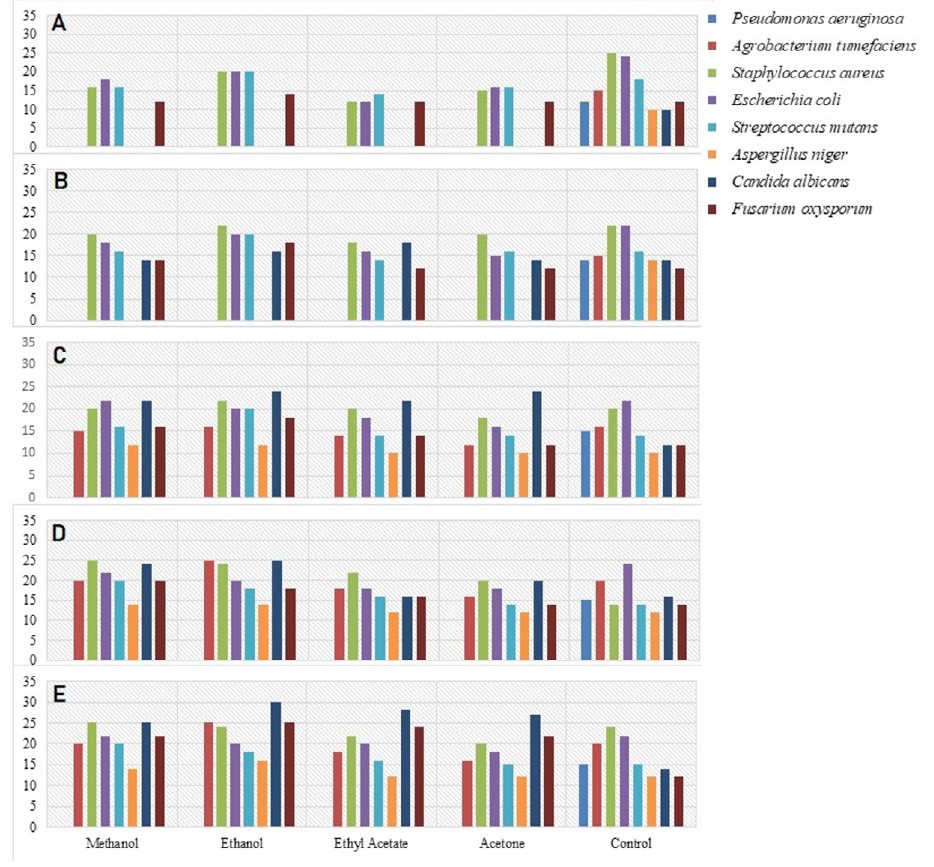
Fig. 4. Inhibitory zones recorded from the antimicrobial activity of extract from Cetrelia braunsiana : A) Inhibitory zone variations in 2.5 mg/ml extract. B) Inhibitory zone variations in 05 mg/ml extract. C) Inhibitory zone variations in 10 mg/ml extract. D) Inhibitory zone variations in 15 mg/ml extract. E) Inhibitory zone variations in 20